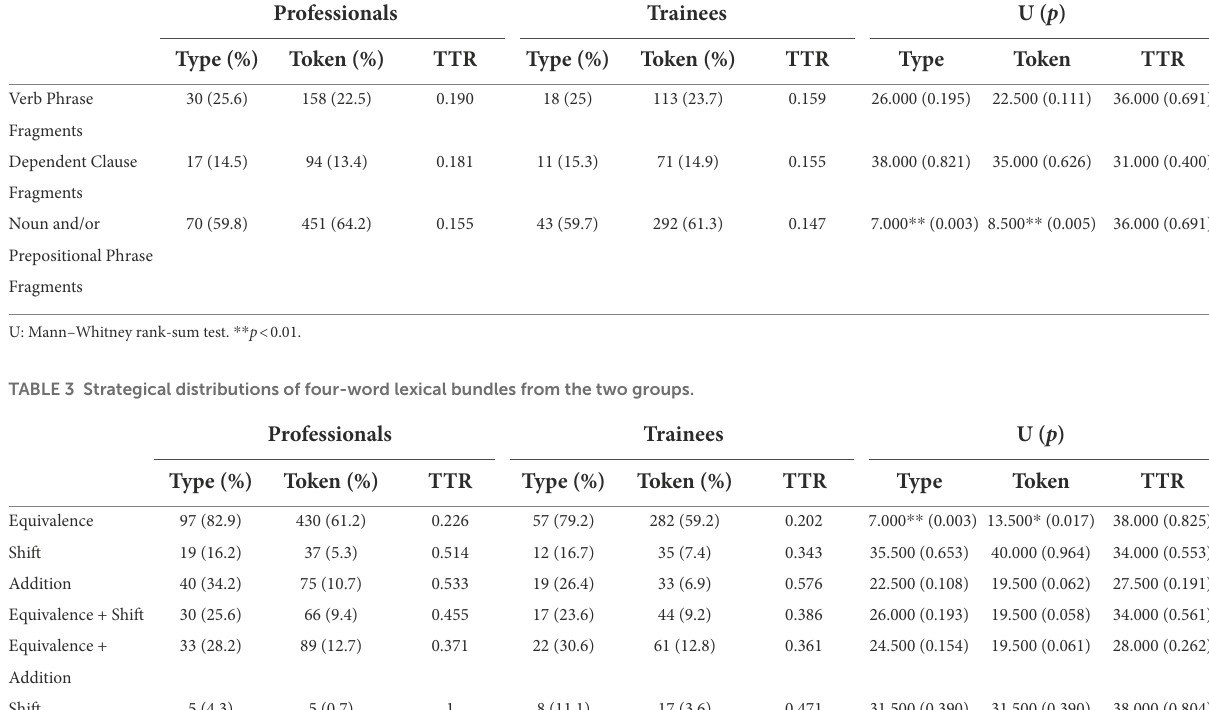
TABLE 2 Structural distributions of four-word lexical bundles from the two groups.